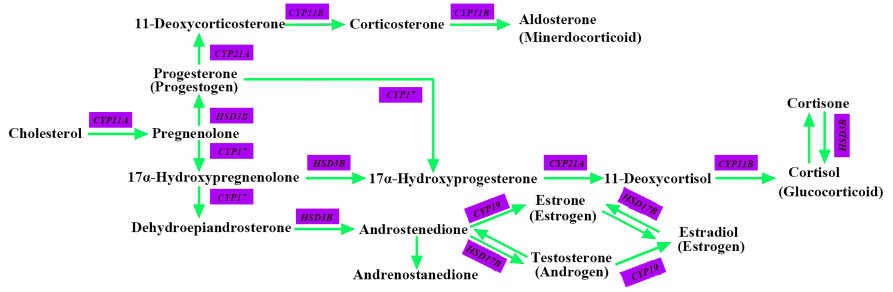
Figure 6. Overview of the steroid hormone biosynthetic